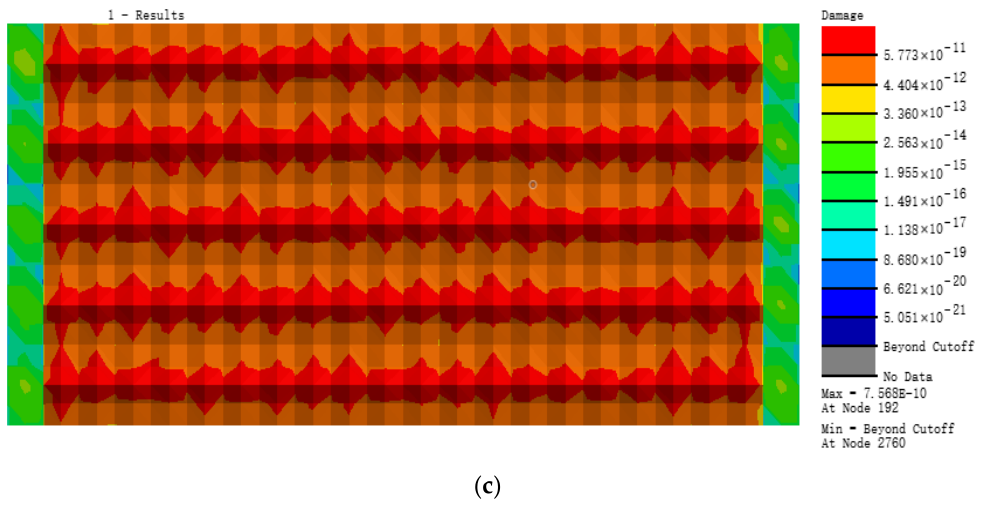
Figure 7. Nephograms of fatigue damage for three models: ( a ) irregular surface, ( b ) hexagonal surface, and ( c ) quadrilateral surface models.